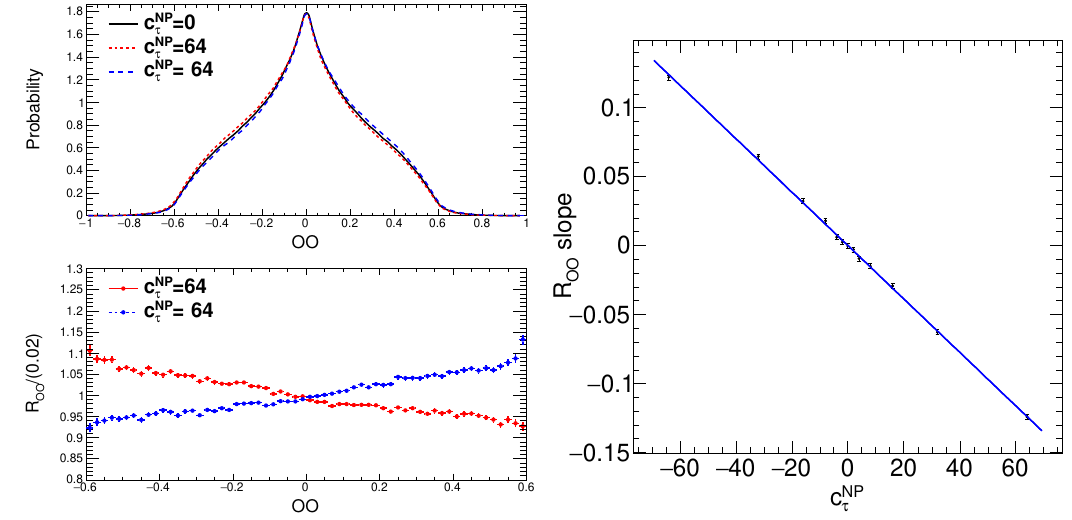
Figure 7 . The probability distributions of OO and R OO as a function of OO for di(cid:11)erent c NP (left), and the R OO slope as a function of c NP to 50 fb (cid:0) 1 of